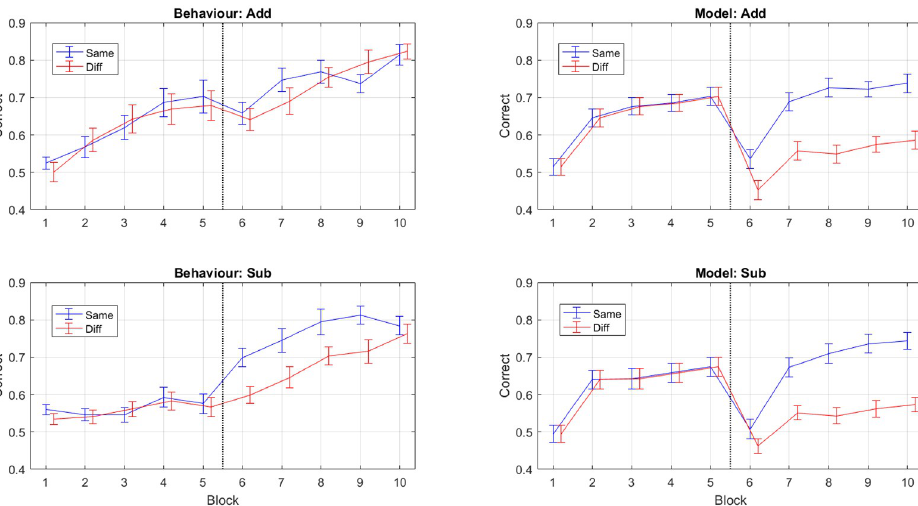
Fig 6. Behavioural and Model Learning Trajectories. The behavioural learning trajectories are averaged over 40 subjects for each of the Sub and Add subspaces. The model learning trajectories are 40 simulations from the minimal capacity neural net model for each of the Sub and Add subspaces. Each block comprises 50 trials and the vertical line denotes that blocks 1 to 5 are from Task 1, and 6 to 10 from Task 2. All error bars indicate the standard error of the mean and the red and blue curves have been offset to improve